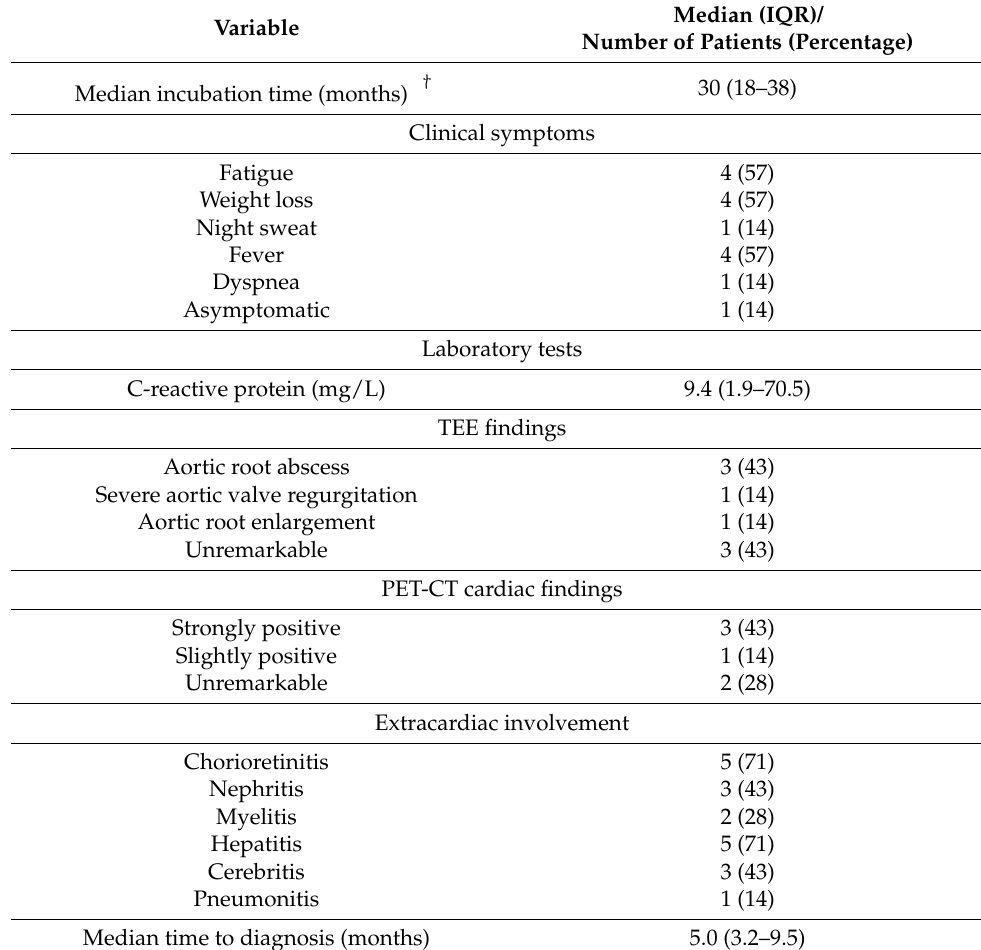
Table 2. Patients’ clinical and paraclinical findings.